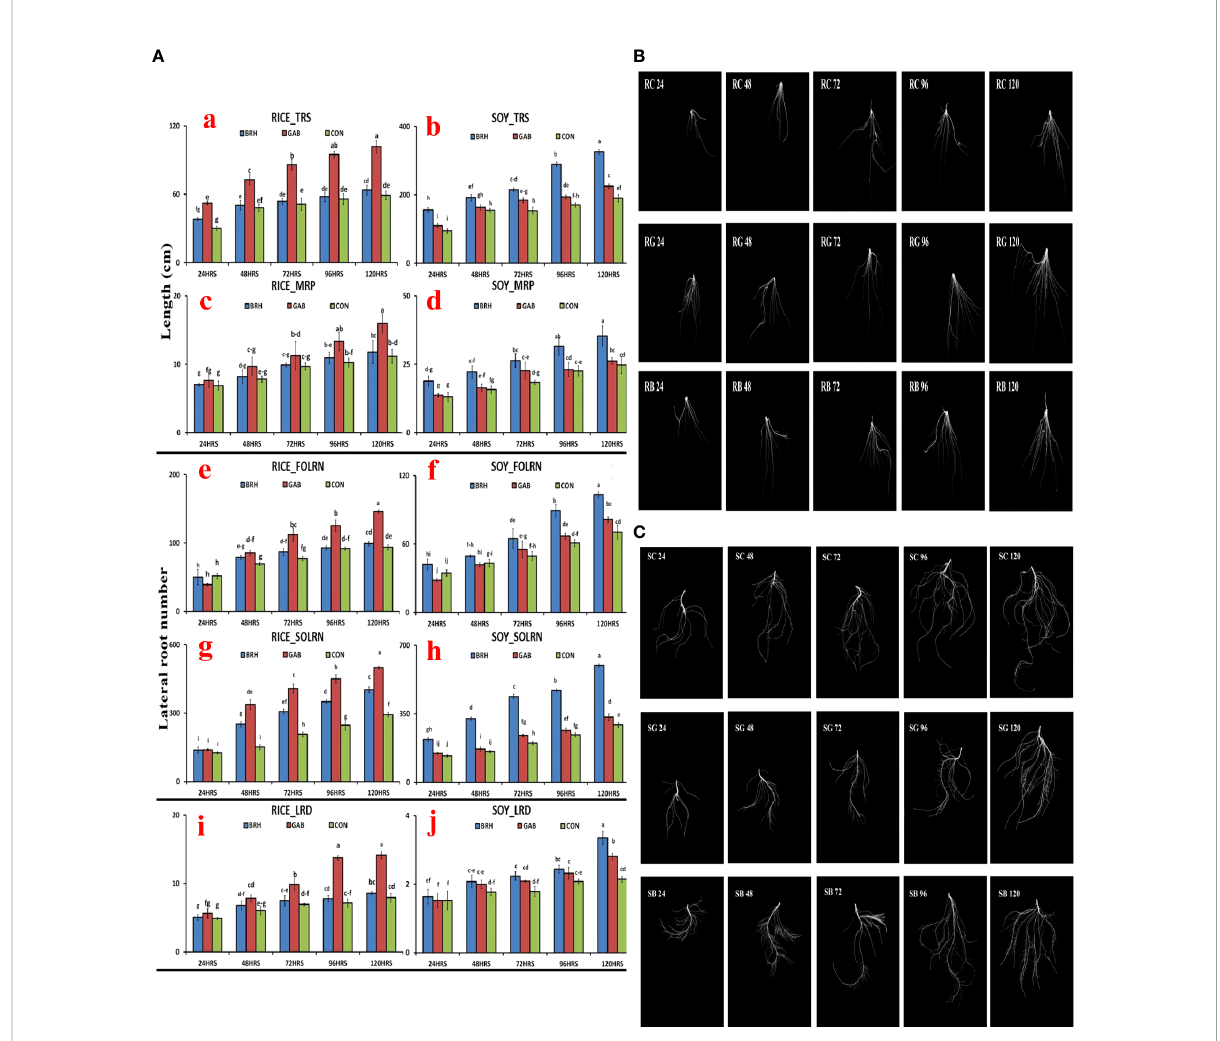
FIGURE 3 (A) Root system architecture (RSA) parameters of the two crops, rice and soybean, after inoculation with Gluconacetobacter diazotrophicus (GAB) and Bradyrhizobium japonicum (BRH); (a) Total root size (TRS) of rice; (b) TRS of soybean; (c) Main root path length of seminal root (MRP) of rice; (d) MRP of soybean; (e) fi rst-order lateral root number (FOLRN) of rice; (f) FOLRN of soybean; (g) second-order lateral root number (SOLRN) of rice; (h) SOLRN of soybean; (i) lateral root density (LRD) of rice; (j) LRD of soybean. (B) Changes in the RSA of rice with different diazotrophs at different time points (24 – 120 h after inoculation). First row – Rice-control; Second row – Rice-GAB; Third row – Rice-BRH. (C) Changes in the RSA of soybean with different diazotrophs at different time points (24 – 120 h after inoculation). First row –